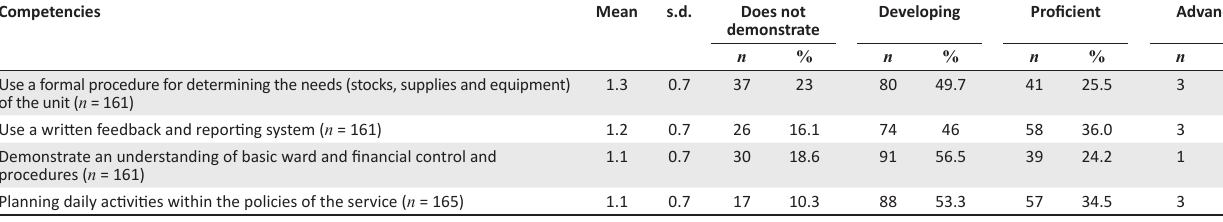
TABLE 5: Competence rating for management. Competencies